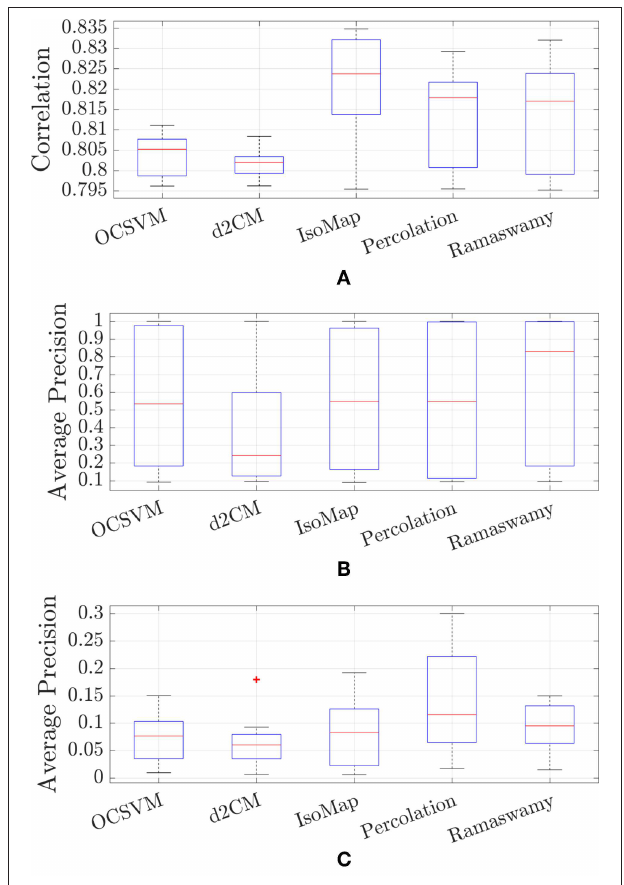
FIGURE 8 | Box-plot summarizing the results of all the outlier finding methods in all the databases. (A) Anterior Chamber OCT images, (B) Face database (only testing groups), (C) Credit Card transactions (only testing